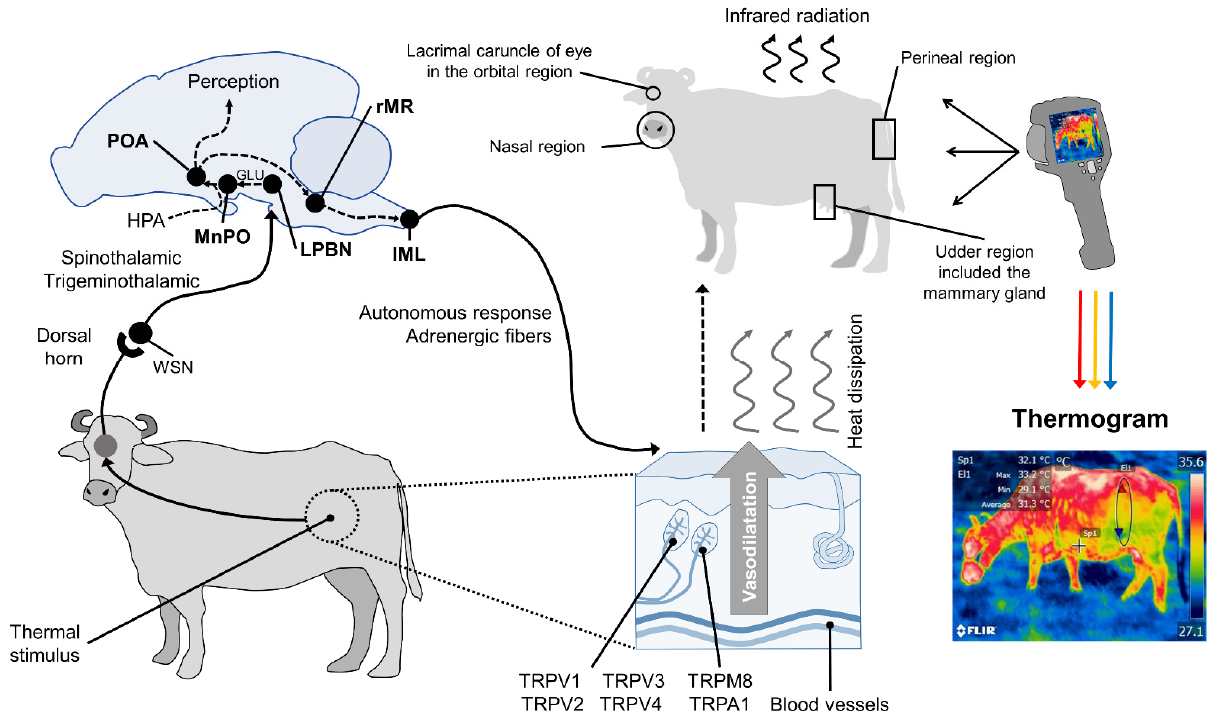
Figure 1. Hypothalamic neuromodulation of thermoregulation and its cutaneous response. In mammals, the thermoreg- ulatory response begins on the periphery with thermoreceptors in the dermis, mostly heat-activated transient receptor potential vanilloids (TRPV, TRPV1, TRPV2, TRPV3, TRPV4), or cold receptors, called melastatin-related transient receptor potentials (TRPM8, TRPA1). These receive afferent information from a thermal stimulus and send the signal to the laminae of the dorsal horn of the spinal cord. The heat-sensitive (WSN) spinothalamic and trigeminothalamic neurons in this zone relay the impulse to third-order neurons in brain structures, such as the lateral parabrachial nucleus (LPBN). From there, they are projected by glutamatergic influence (GLU), to the median preoptic nucleus (MnPO) in the preoptic area (POA) of the hypothalamus. The hypothalamic network is responsible for integrating behavioral, neuroendocrine (mediated by the hypothalamic–pituitary–adrenal axis (HPA)), and autonomic thermoregulatory effector responses. Autonomic action, mediated by sympathetic adrenergic ganglia that receive information from the rostral medullary raphe (rMR) and lateral intermediolateral nucleus of the spinal cord (IML), induces cutaneous vasodilatation with the consequent dissipation of heat in the form of infrared radiation through certain body regions, known as thermal windows (e.g., the lacrimal caruncle of the eye in the orbital region ( regio orbitalis ), the muzzle in the nasal region ( region nasalis ), the mammary gland in the udder region ( regio uberis ), and the vulva of the urogenital region ( regio urogenitalis ). Infrared thermographic cameras can capture the radiation emitted through the skin using a color code that makes it possible to determine the minimum, mean, and maximum temperatures of the thermal window